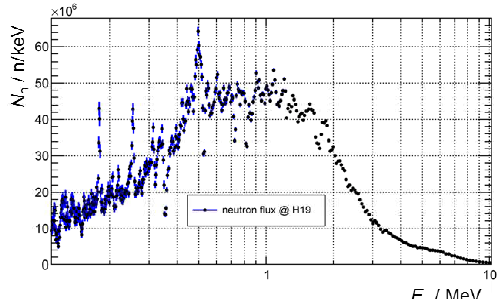
Figure 4. Neutron fluence determined from the 235 U fission chamber data.